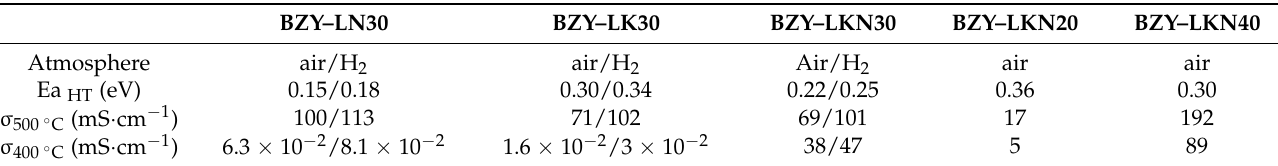
Table 2. Calculated activation energies and conductivities for BZY–alkali carbonate composites. Ea HT corresponds to the activation energies in the high-temperature